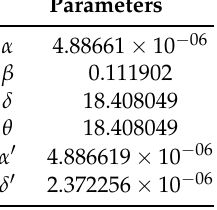
Table 2 quotes the summary statistics of the probability distribution of the lifetime T 65 at age